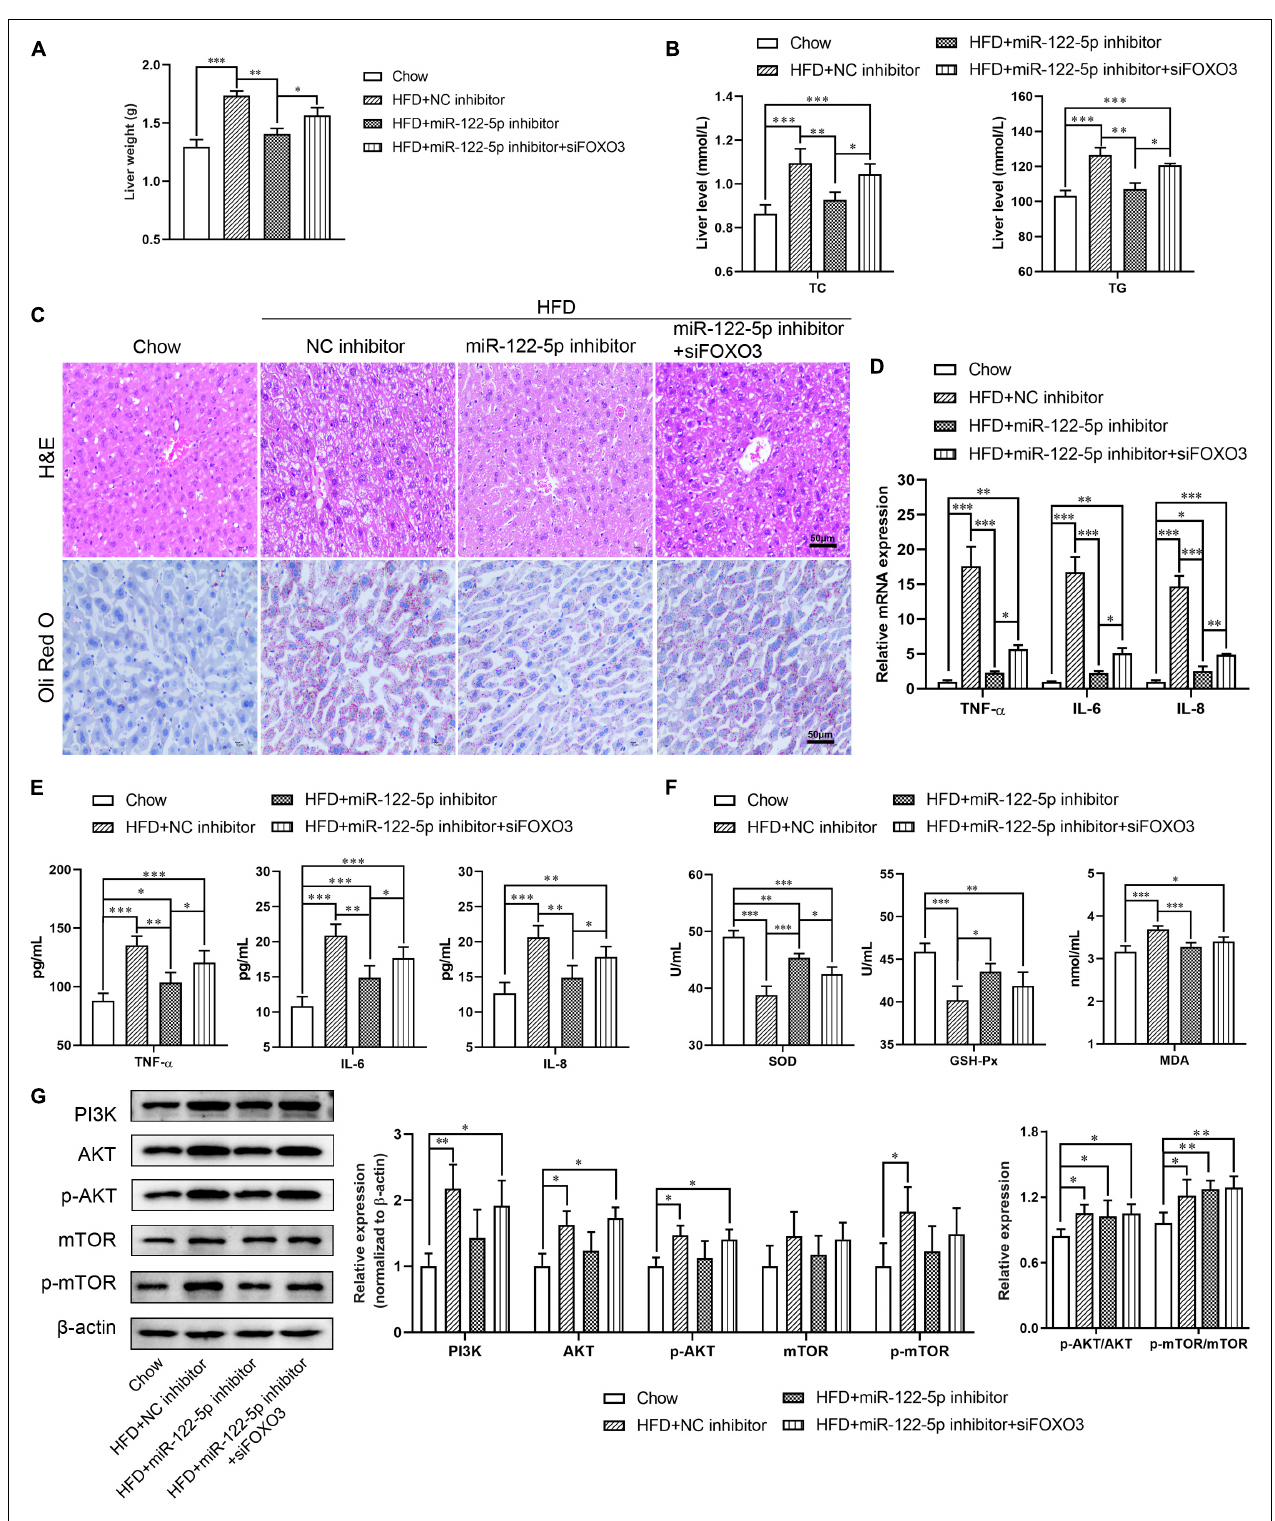
FIGURE 5 | Silence FOXO3 abolishes the benefits of miR-122-5p inhibition in hepatic tissue. (A) Liver weight. (B) Hepatic TC and TG. (C) H&E and Oli Red O staining for liver morphological characteristics. (D) RT-qPCR analyzed the expression of TNF- α , IL-6, and IL-8. (E) ELISA analyzed the level of TNF- α , IL-6, and IL-8 in liver tissue. (F) The activity of SOD and GSH-Px, and the content of MDA. (G) Western blot analysis of PI3K, AKT, p-AKT, mTOR, and p-mTOR expression. Error bars indicate SD. ∗ P < 0.05, ∗∗ P < 0.01, ∗∗∗ P < 0.001.